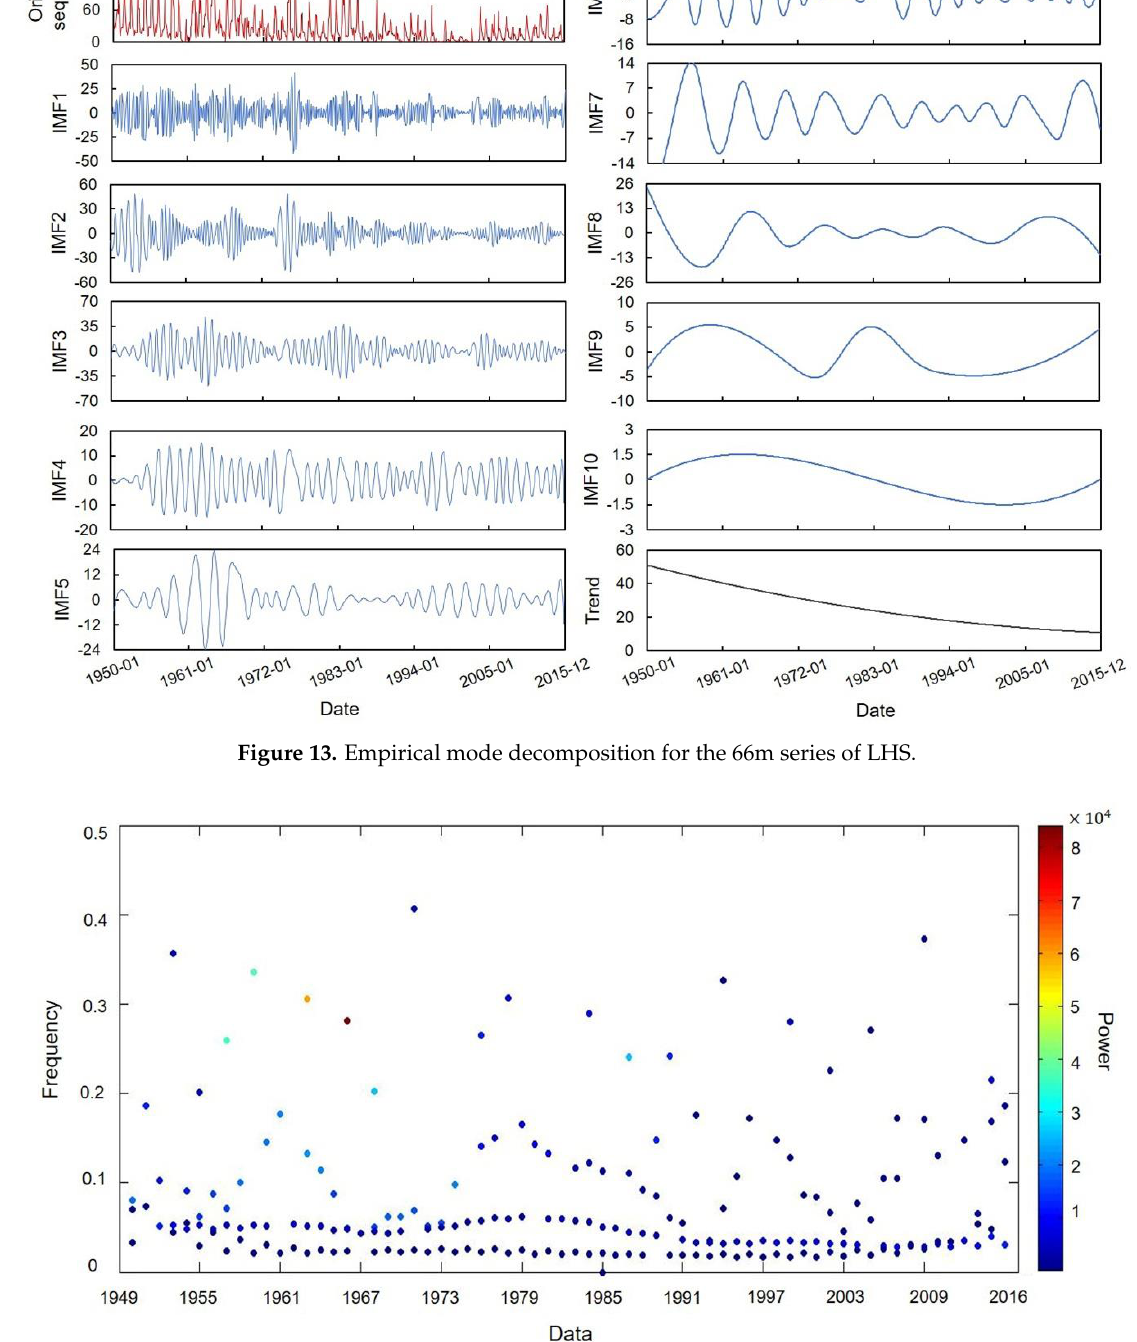
Figure 14. The Hilbert spectrum for the 67 a series of HHS.